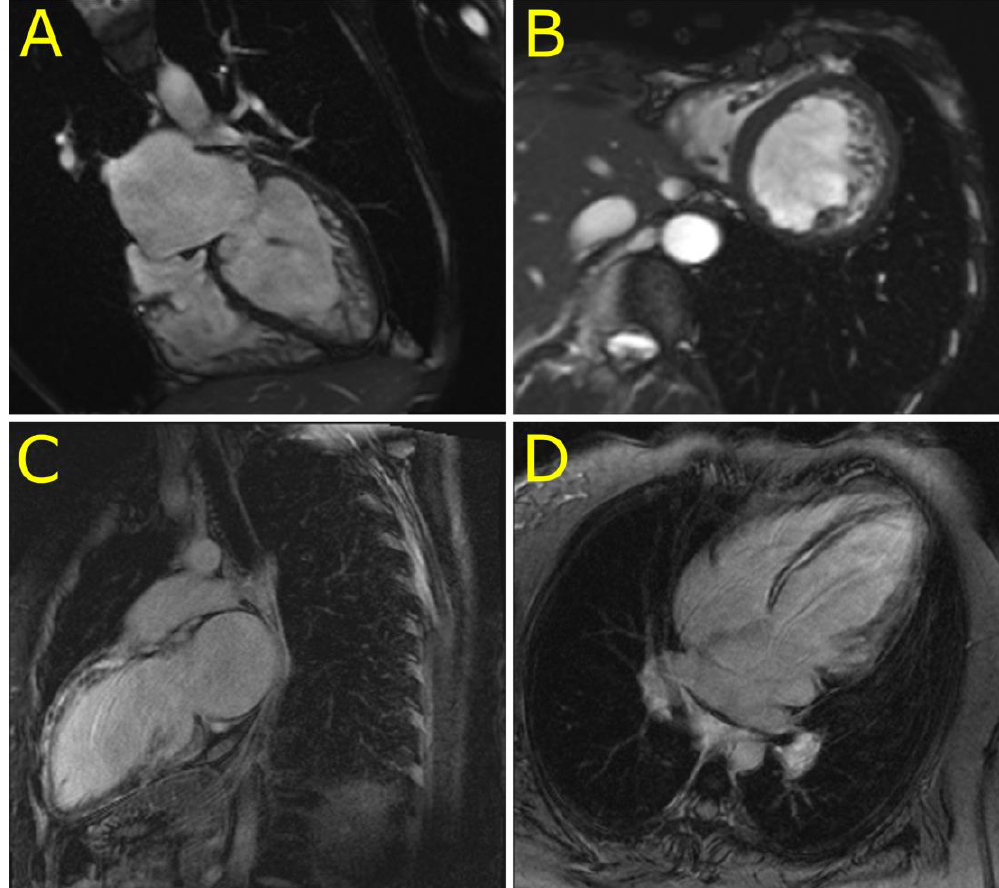
Figure 3. Cardiovascular magnetic resonance imaging in patients with left ventricular non-compaction cardiomyopathy (P4) and dilated cardiomyopathy with an extensive late gadolinium enhancement (P2). ( A, B ): Four chamber and short axis views of left ventricular non-compaction cardiomyopathy in P4. ( C, D ): Two chamber long axis and four chamber views of an extensive late gadolinium enhancement in the ventricular septum and left ventricular anterior wall mimicking inflammatory cardiomyopathy in P2.